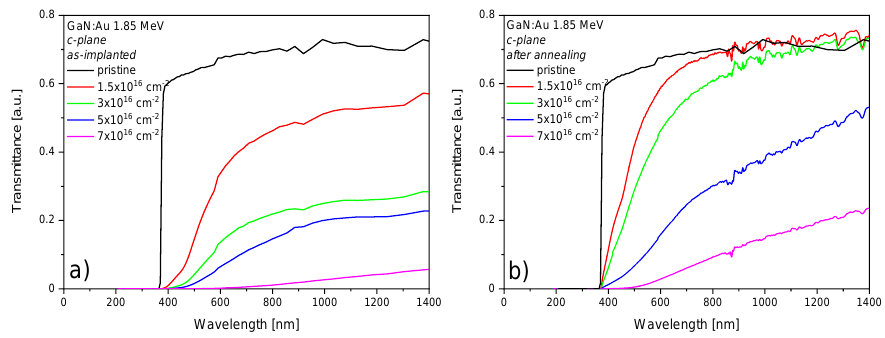
Fig. 4. Optical transmittance spectra of the pristine and Au-ion implanted GaN in a) and the subsequently annealed GaN samples in